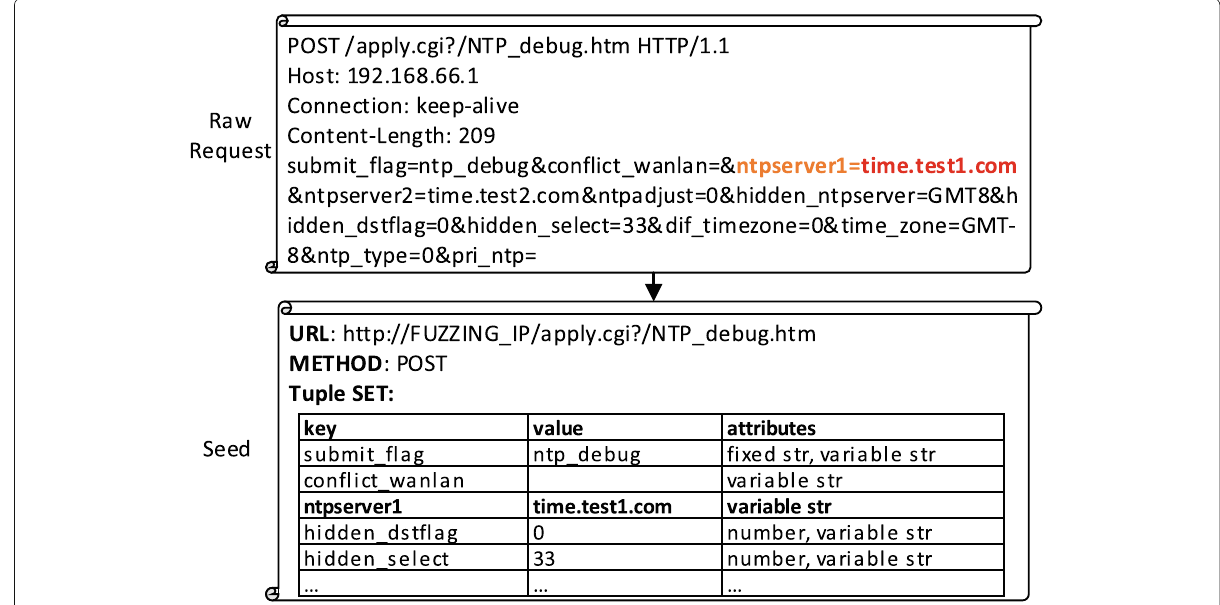
Fig. 4 Parsing raw request to seeds